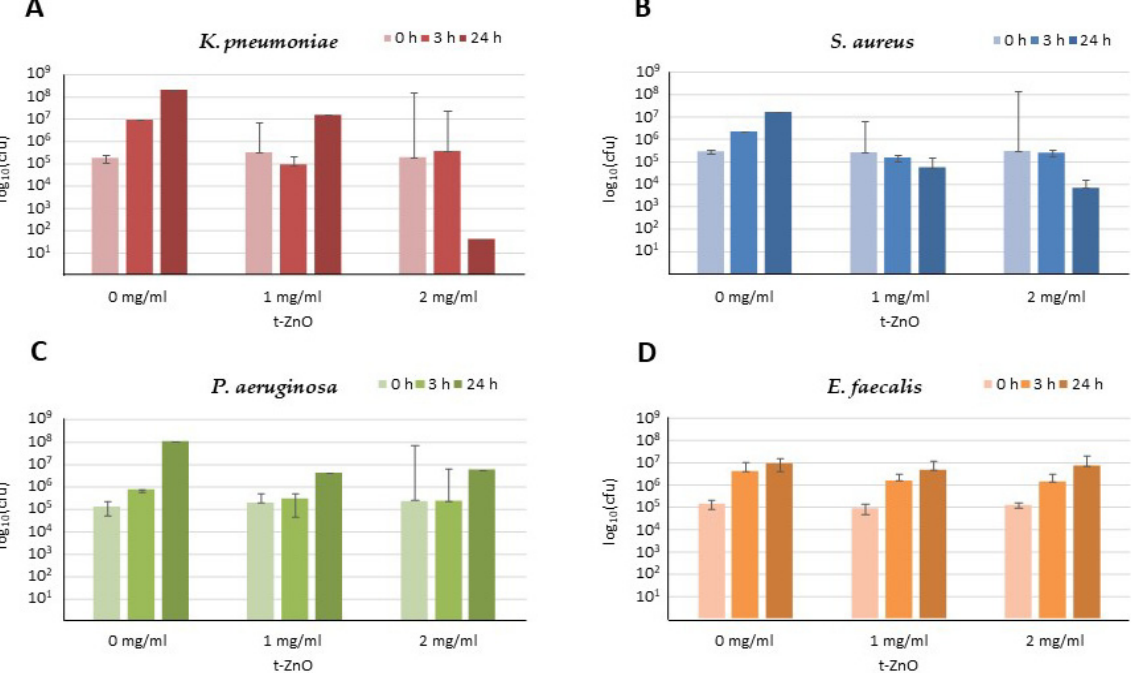
Figure 2. Orientating antibacterial testing of untreated ZnO tetrapods against ( A ) K. pneumoniae , ( B ) S. aureus , ( C ) P. aeruginosa , and ( D ) E. faecalis in means of independent triplicate values with standard deviations. Drug concentrations are shown in mg/mL. cfu = colony forming units.